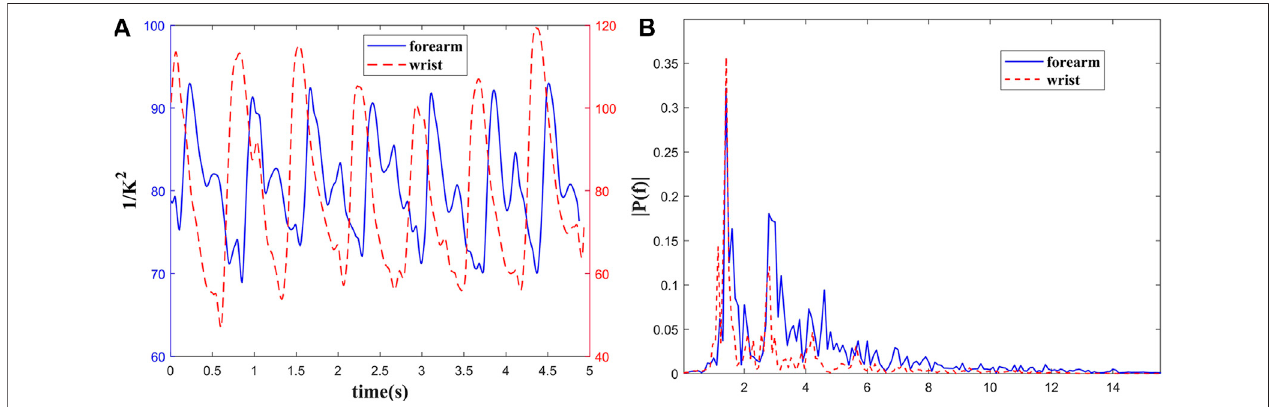
FIGURE 3 | Blood fl ow measurement of a healthy subject ’ s (A) forearm and wrist; (B) the power spectrum of pulse